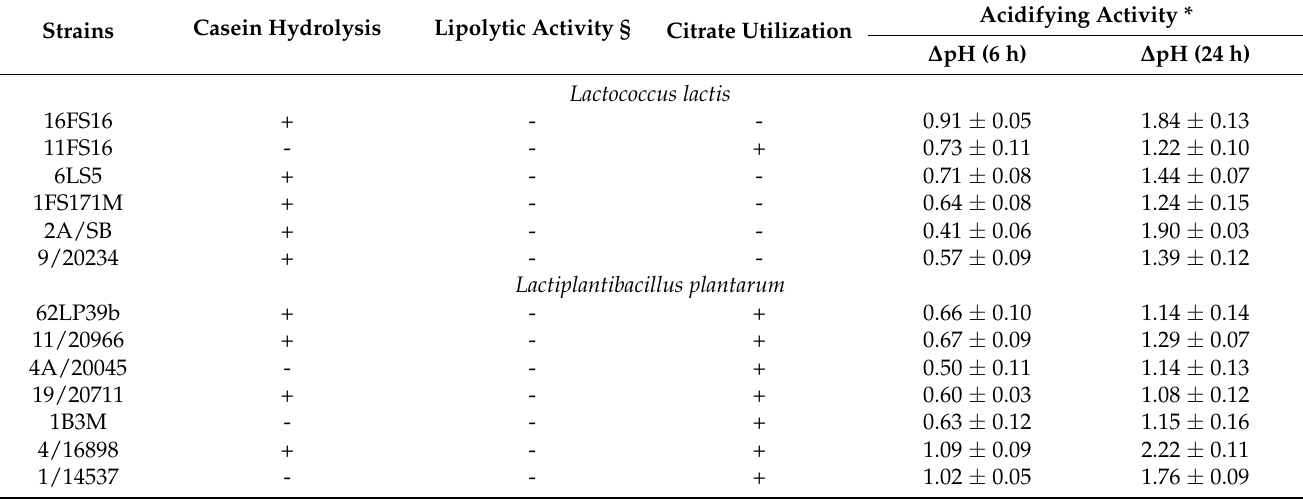
Table 1. Technological characteristics of the autochthonous